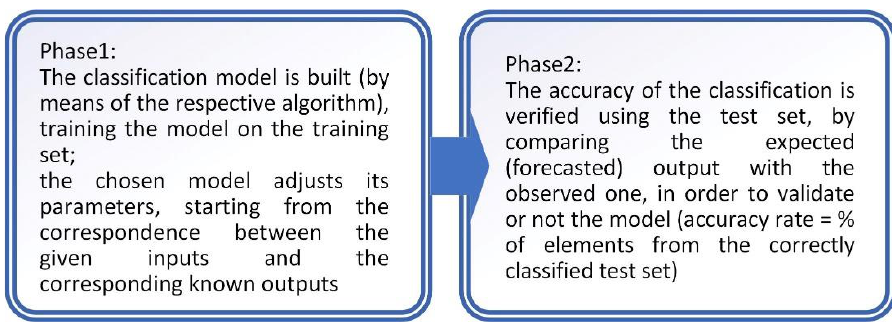
Figure 3. Classification process.